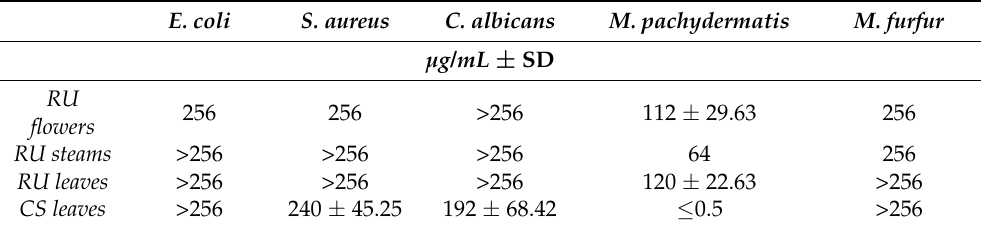
Table 4. MIC of freeze-dried extracts of R. usambarensis aerial parts and C.sinensis leaves. E.